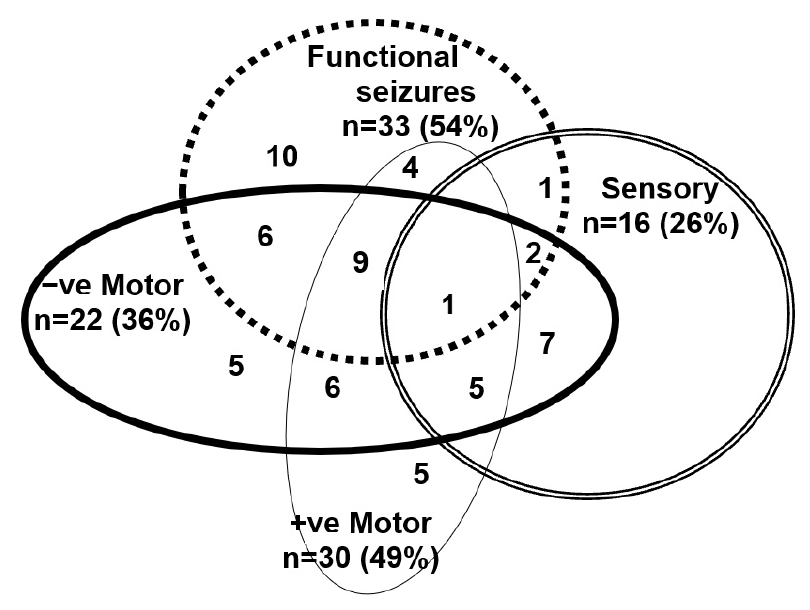
Figure 1. Visual depiction of functional neurological symptoms—past of current—experienced by the young people in the FND cohort.